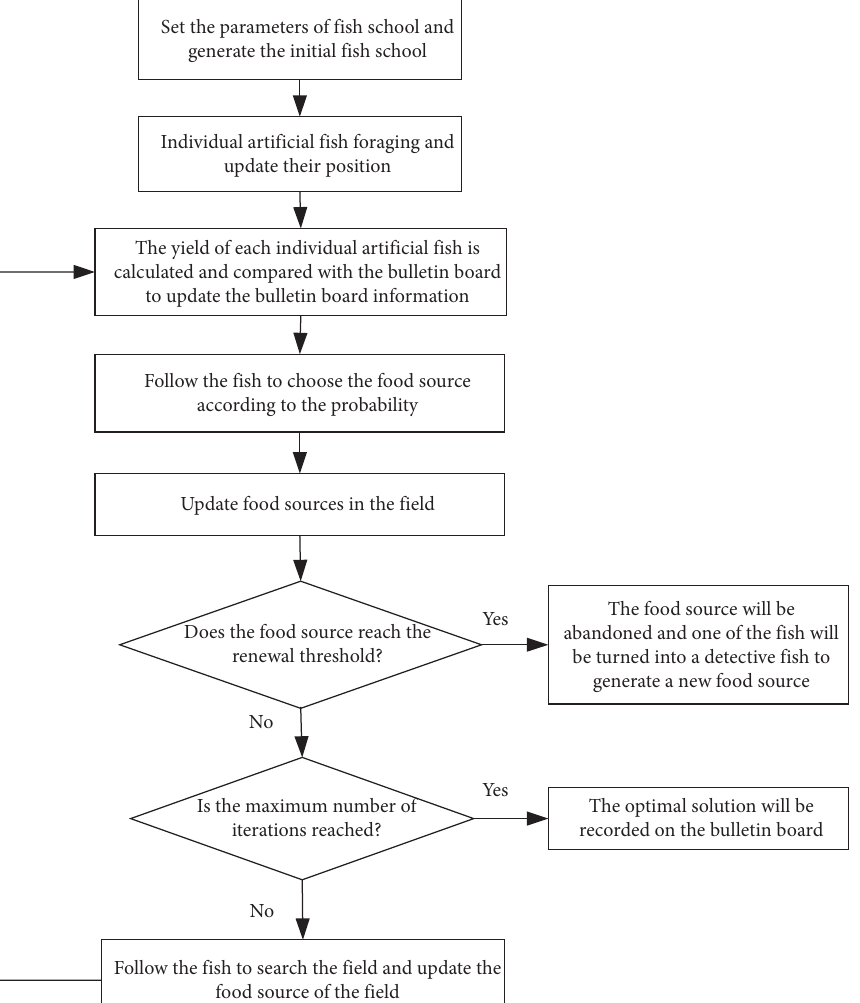
Figure 1: Parameter optimization of kernel extreme learning machine based on artificial fish swarm optimization